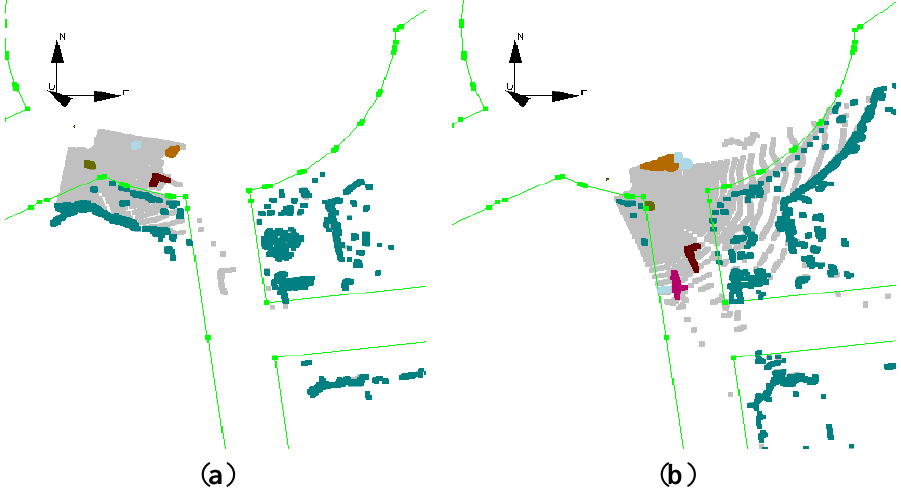
Figure 9. ( a , b ) Cyclist and car are correctly tracked. However, few static objects are incorrectly labeled as moving